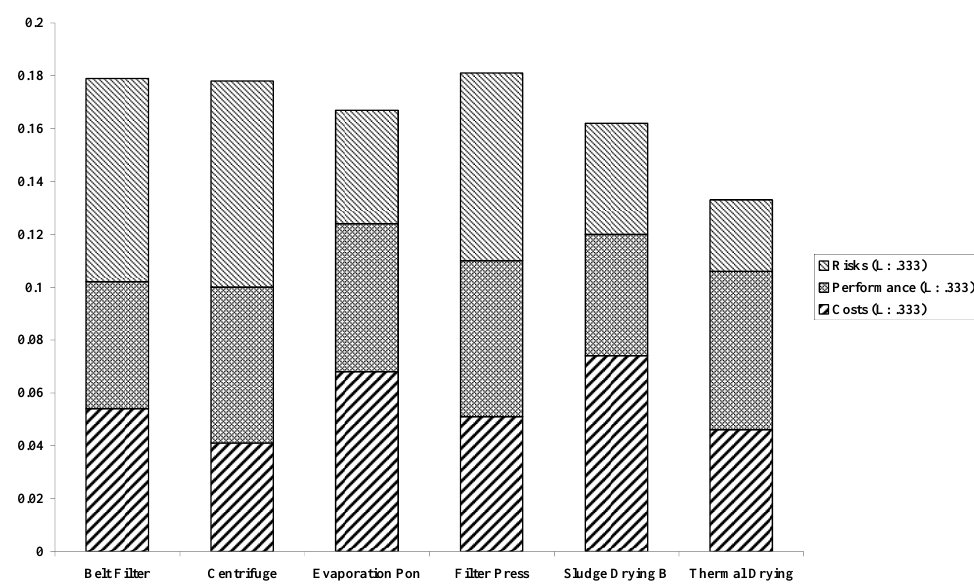
Figure 6. Comparative results of sludge dewatering